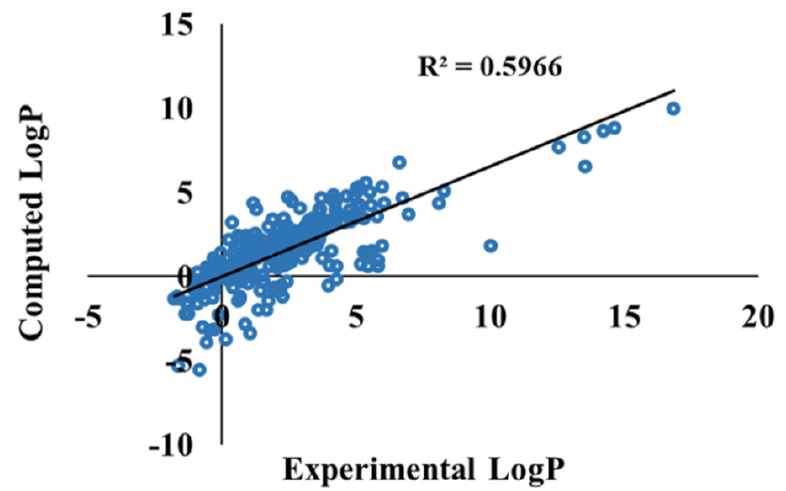
Figure 2. Correlation between experimental and 3D-RISM-KH computed ketone–water partition coefficients.